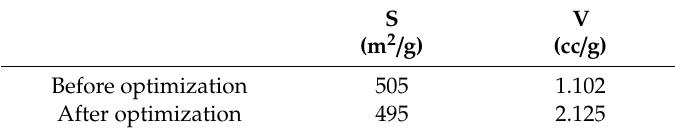
Figure 11. Comparison of SEM of PB before and after optimization. Table 5. Comparison of pore properties of PB before and after optimization.